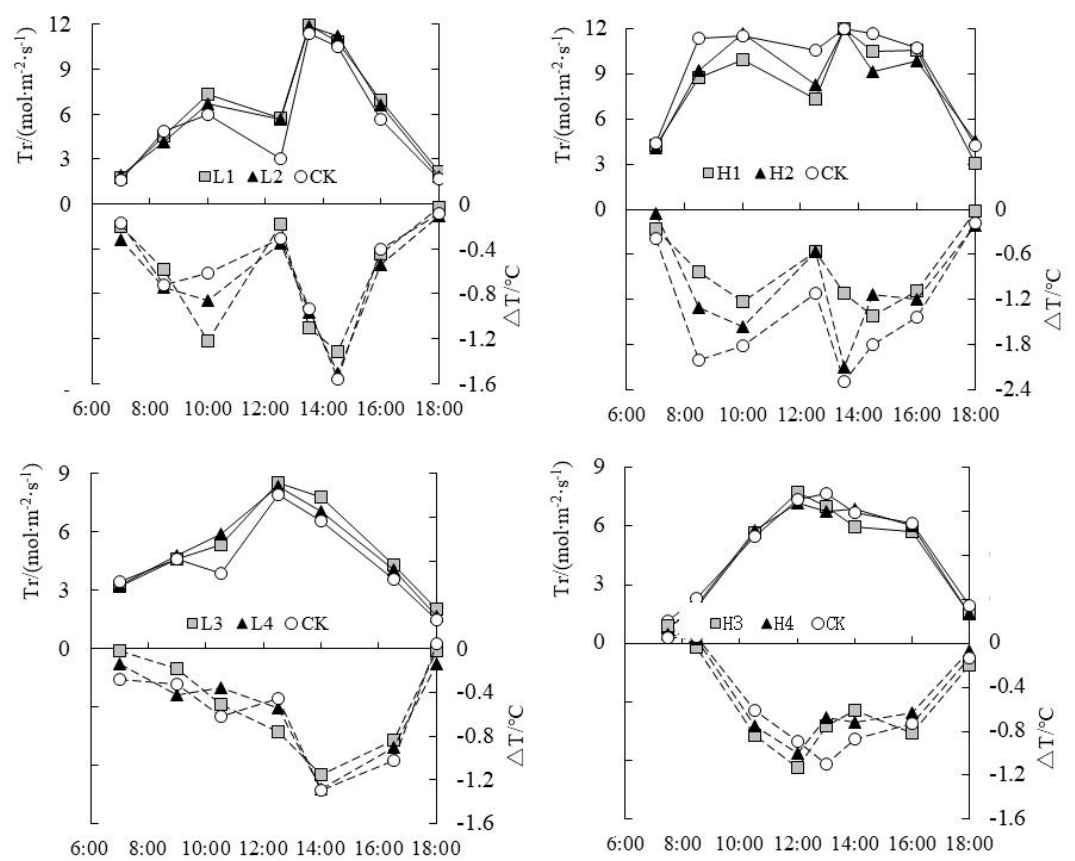
Figure 3. Daily change of temperature difference ( ∆ T) and evapotranspiration rate (Tr) under water level control.